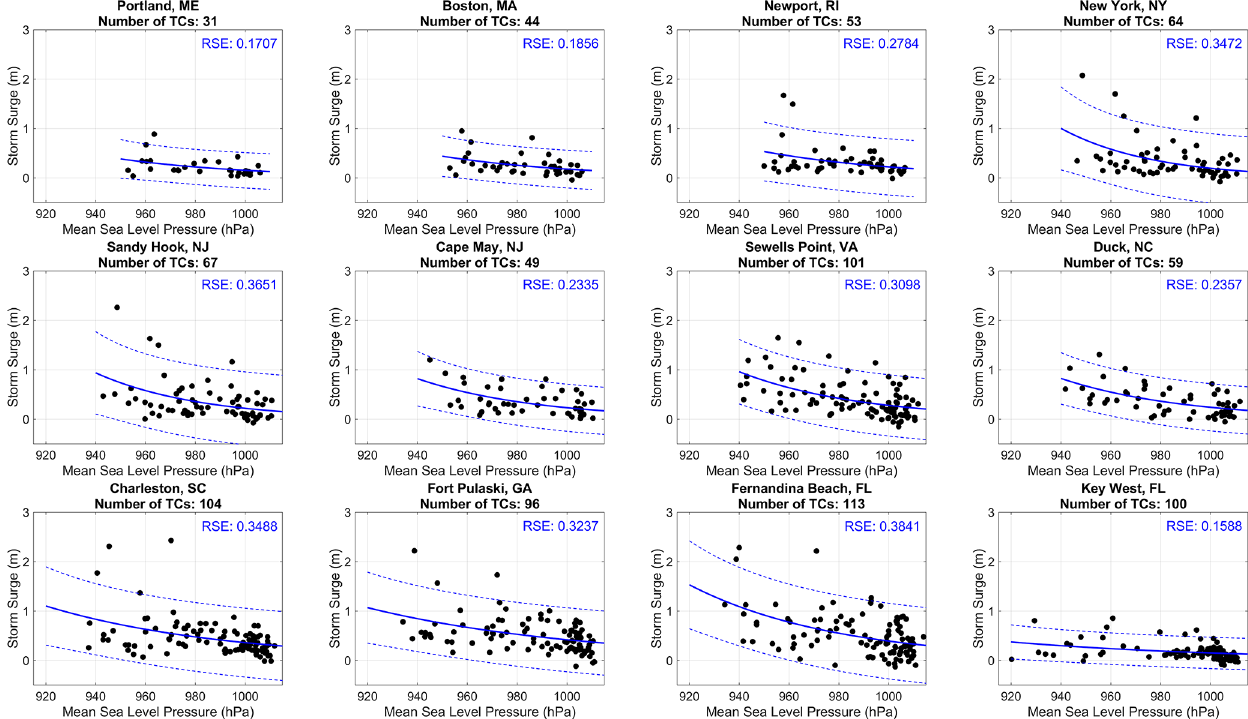
Figure 3. Exponential fit (blue solid line) between storm surge (m) and MSLP (hPa) with 95% confidence intervals (dashed line) for all TCs within 500km. Residual standard error (RSE) is provided for the exponential